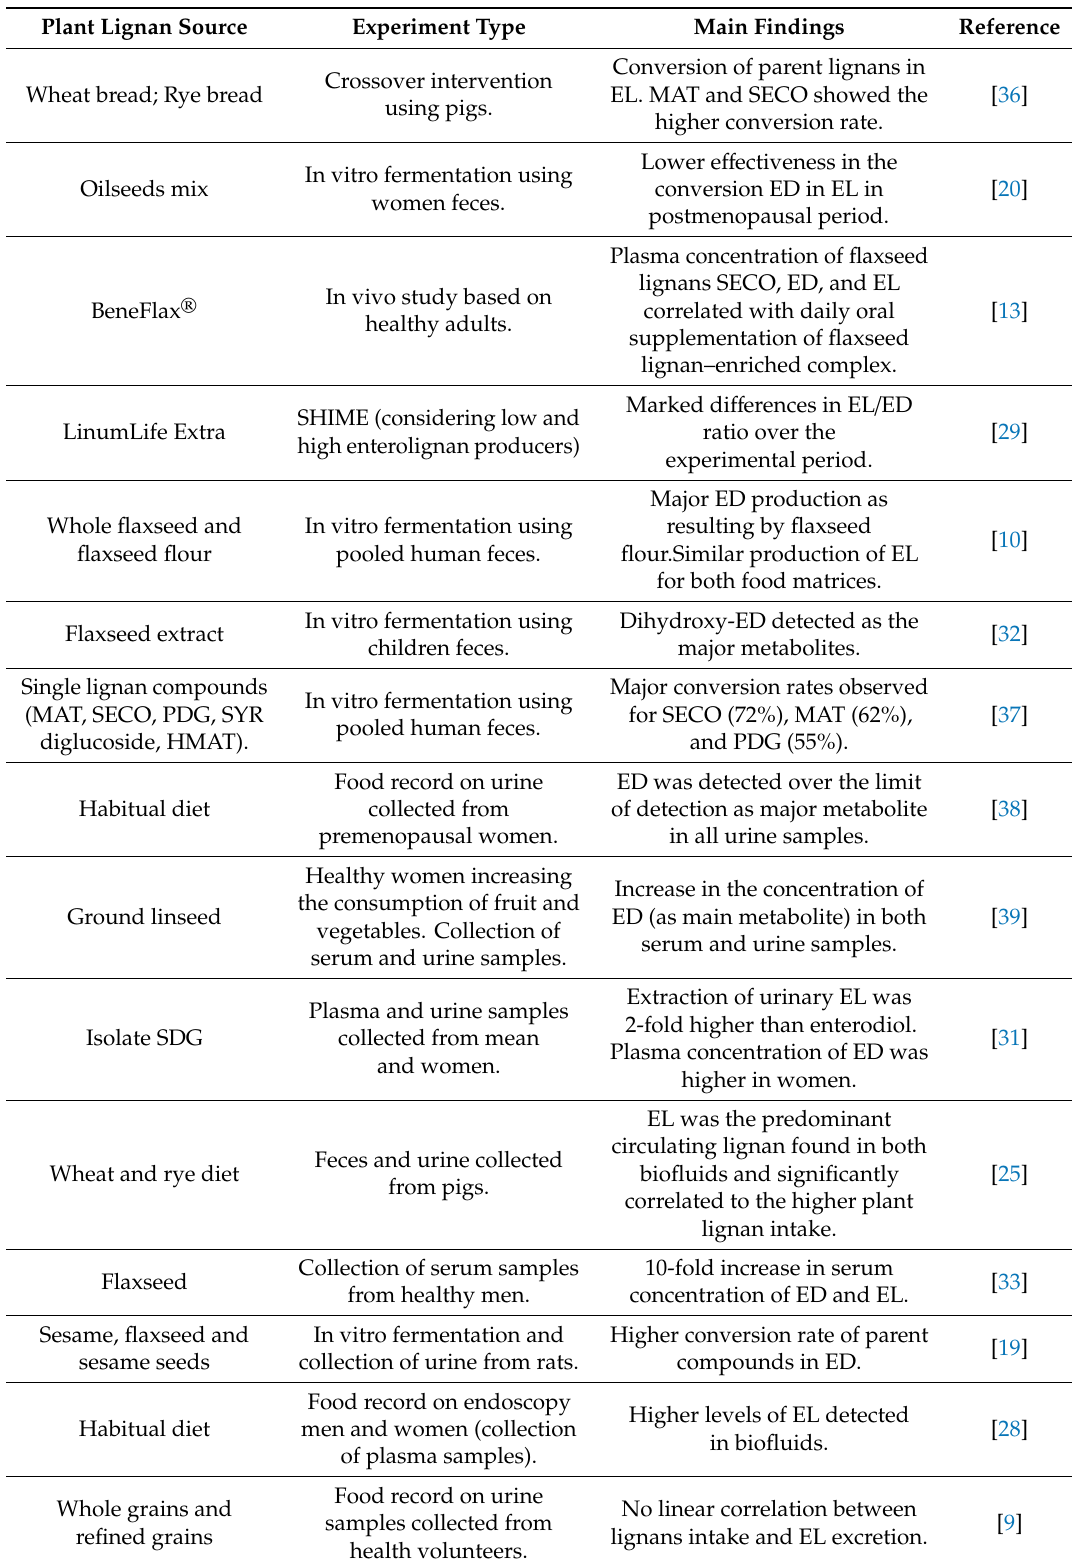
Table 2. Studies summarizing the production of lignan metabolites (enterodiol and enterolactone) following the intake of lignans from di ff erent plant